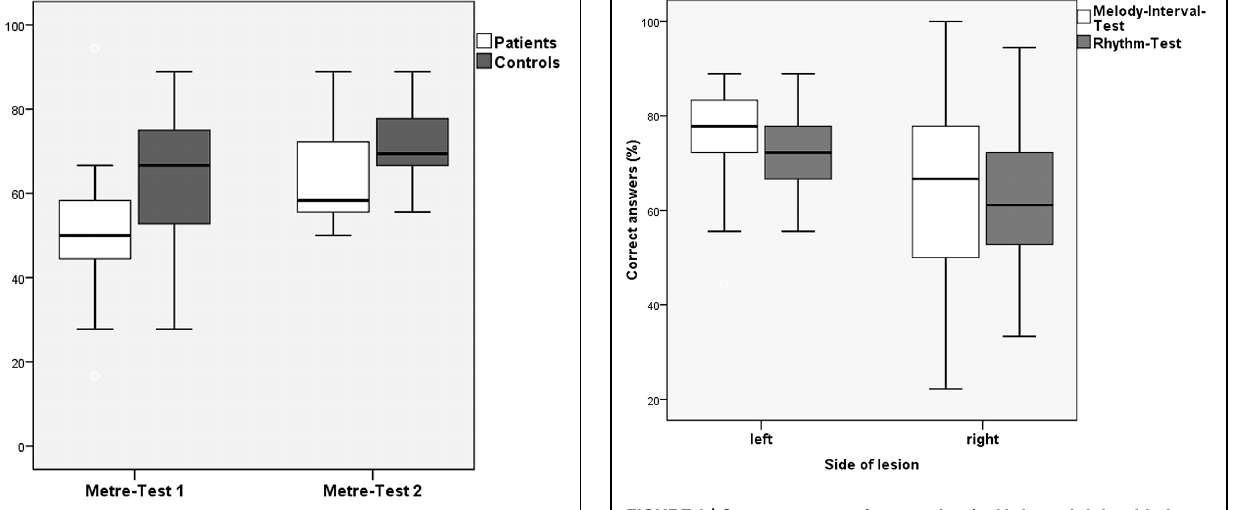
FIGURE 2 | Correct answers (mean values) of patients and controls for Metre Test 1 vs. Metre Test 2 (error bars indicate one standard deviation).